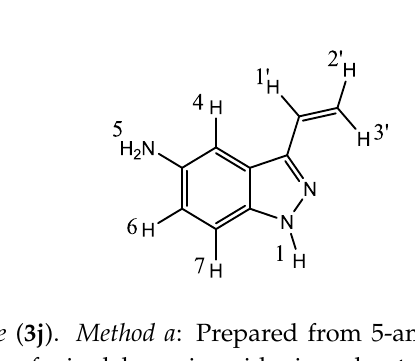
1a . Figure S2: 13 C-NMR spectrum of 1a . Figure S3: 1 H-NMR spectrum of 1b . Figure S4: 13 C-NMR spectrum of 1b . Figure S5: 1 H-NMR spectrum of 1c . Figure S6: 13 C-NMR spectrum of 1c . Figure S7: 1 H-NMR spectrum of 1d . Figure S8: 13 C-NMR spectrum of 1d . Figure S9: 1 H-NMR spectrum of 1e . Figure S10: 13 C-NMR spectrum of 1e . Figure S11: 1 H-NMR spectrum of 1f . Figure S12: 13 C-NMR spectrum of 1f . Figure S13: 1 H-NMR spectrum of 1g . Figure S14: 13 C-NMR spectrum of 1g . Figure S15: 1 H-NMR spectrum of 1h . Figure S16: 13 C-NMR spectrum of 1h . Figure S17: 1 H-NMR spectrum of 1i . Figure S18: 13 C-NMR spectrum of 1i . Figure S19: 1 H-NMR spectrum of 1j . Figure S20: 13 C-NMR spectrum of 1j . Figure S21: 1 H-NMR spectrum of 2a . Figure S22: 13 C-NMR spectrum of 2a . Figure S23: 1 H-NMR spectrum of 2b . Figure S24: 13 C-NMR spectrum of 2b . Figure S25: 1 H-NMR spectrum of 2c . Figure S26: 13 C-NMR spectrum of 2c . Figure S27: 1 H-NMR spectrum of 2d . Figure S28: 13 C-NMR spectrum of 2d . Figure S29: 1 H-NMR spectrum of 3a . Figure S30: 13 C-NMR spectrum of 3a . Figure S31: 1 H-NMR spectrum of 3b . Figure S32: 13 C-NMR spectrum of 3b . Figure S33: 1 H-NMR spectrum of 3c . Figure S34: 13 C-NMR spectrum of 3c . Figure S35: 1 H-NMR spectrum of 3d . Figure S36: 13 C-NMR spectrum of 3d . Figure S37: 1 H-NMR spectrum of 3e . Figure S38: 13 C-NMR spectrum of 3e . Figure S39: 1 H-NMR spectrum of 3f . Figure S40: 13 C-NMR spectrum of 3f . Figure S41: 1 H-NMR spectrum of 3g . Figure S42: 13 C-NMR spectrum of 3g . Figure S43: 1 H-NMR spectrum of 3h . Figure S44: 13 C-NMR spectrum of 3h . Figure S45: 1 H-NMR spectrum of 3i . Figure S46: 13 C-NMR spectrum of 3i . Figure S47: 1 H-NMR spectrum of 3j . Figure S48: 13 C-NMR spectrum of 3j